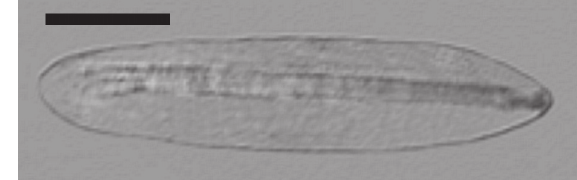
Figure 2 - The exclusive cnidae type of the larval stage of Aulactinia marplatensis : mesobasic p -mastigophore. Scale =